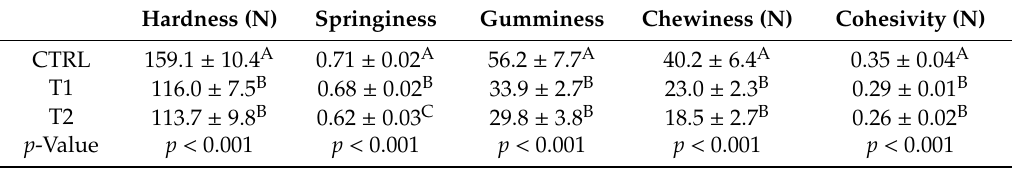
Table 4. Texture profile analysis (TPA) of the beef burger without fat substitution (CTRL) and at 50% (T1) and 100% (T2) of fat substitution with an oat-hull-based gel. Hardness (N) Springiness Gumminess Chewiness (N)